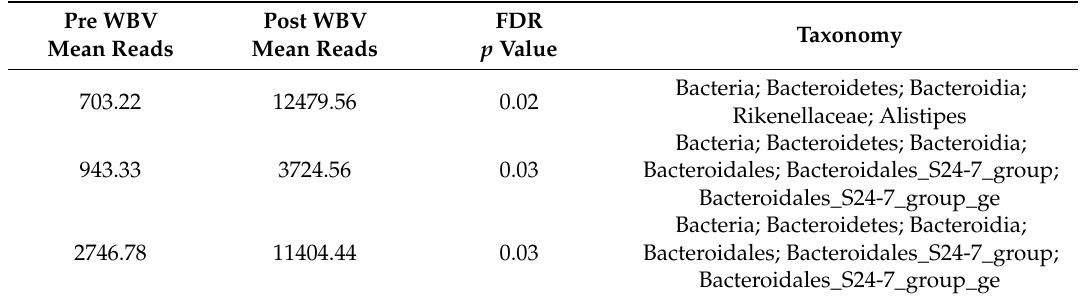
Table 1. Taxa with the most significant increases post WBV. Alistipes increased by 17 times. This analysis combined the pre- / post-WBV results from mice in all